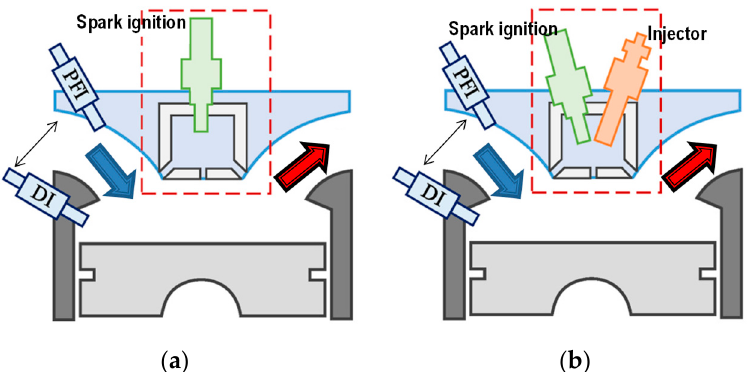
Figure 2. Two-stage combustion systems: ( a ) Passive prechamber; ( b ) Active prechamber [20].